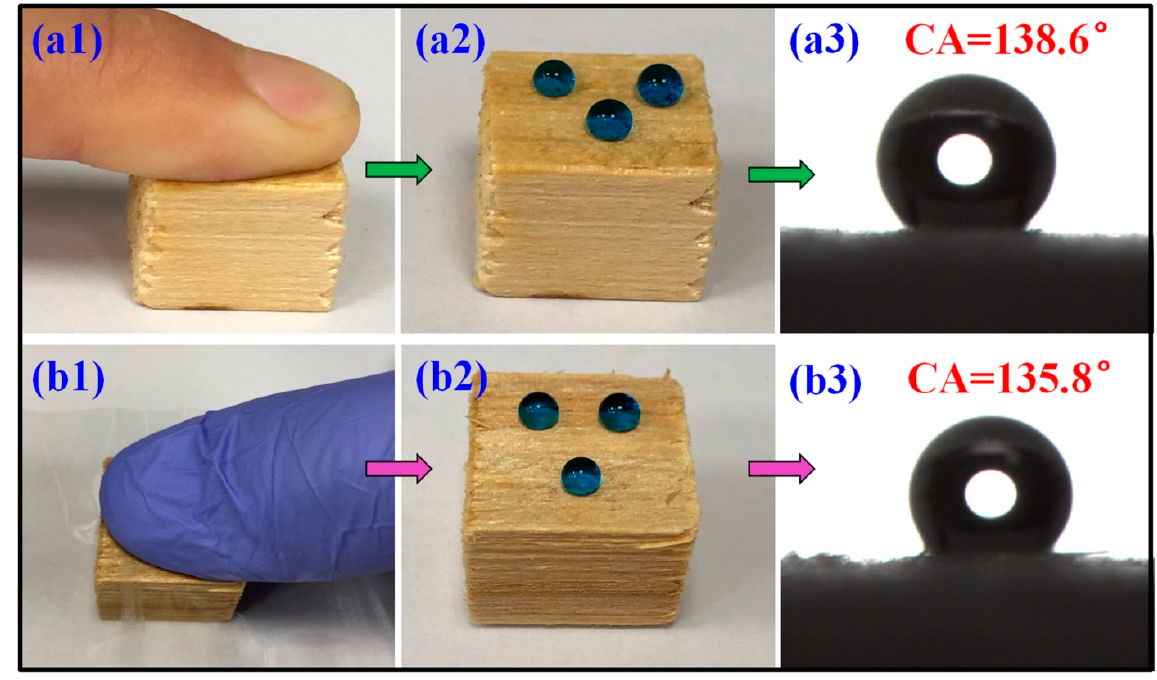
Figure 7. Images of ( a1 – a3 ) finger wiping test and ( b1 – b3 ) tape peeling test.